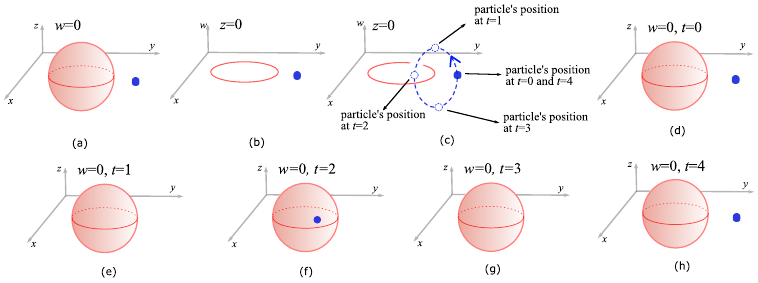
Figure 3 . Observing the particle-membrane braiding described by CdA term in 3 D space. (a) A membrane (red) with the shape of a 2 -sphere in xyz -space with w = 0 and a particle (blue) are illustrated. This membrane is assumed to be static in space. (b) If observed in xyw -space with z = 0 , this membrane appears as a “loop”. (c) In xyw -space with z = 0 , the particle-membrane braiding in 4 D space looks like a particle-loop braiding. Starting at t = 0 , the particle moves in the xyw -space with z = 0 and returns to its initial position at t = 4 . The particle’s spatial trajectory forms a closed 1 D curve that is linked with the “loop” (projection of membrane in this 3 D space). The w -coordinate of particle, w p , varies in the following way: at t = 0 , w p = 0 ; for 0 < t < 2 , w p > 0 ; at t = 2 , w p = 0 again; for 2 < t < 4 , w p < 0 ; finally, the particle returns to its initial position thus w p = 0 at t = 4 . (d)–(h) Snapshots of particle-membrane braiding at different moments in xyz -space with w = 0 . At t = 0 , the particle is located outside the membrane. At t = 2 , the particle appears inside the membrane. At t = 4 , this particle returns to its starting position; in xyz -space with 0 , it appears outside the membrane again. For other moments, the particle is located in xyz -space with w 6 = 0 . In 4 D space, Ξ 1 in eq. (2.4) is projected to a 3 D Seifert hypersurface and γ 1 in that appears as a closed 1 D spatial trajectory. In xyw -space with w = 0 shown in (c), the aforementioned 3 D Seifert hypersurface appears as a 2 D one whose boundary is exactly the “loop”. The spatial trajectory and the 2 D Seifert surface intersect at one point at t = 2 implying that | # (Ξ 1 ∩ γ 1 ) | = 1 with a sign determined by orientation. In xyz -space with w = 0 shown in (d)-(h), the spatial trajectory is the union of particle’s positions at different moments which intersects with the 3 D Seifert hypersurface at t = 2 . This also indicates | # (Ξ 1 ∩ γ 1 ) | = 1